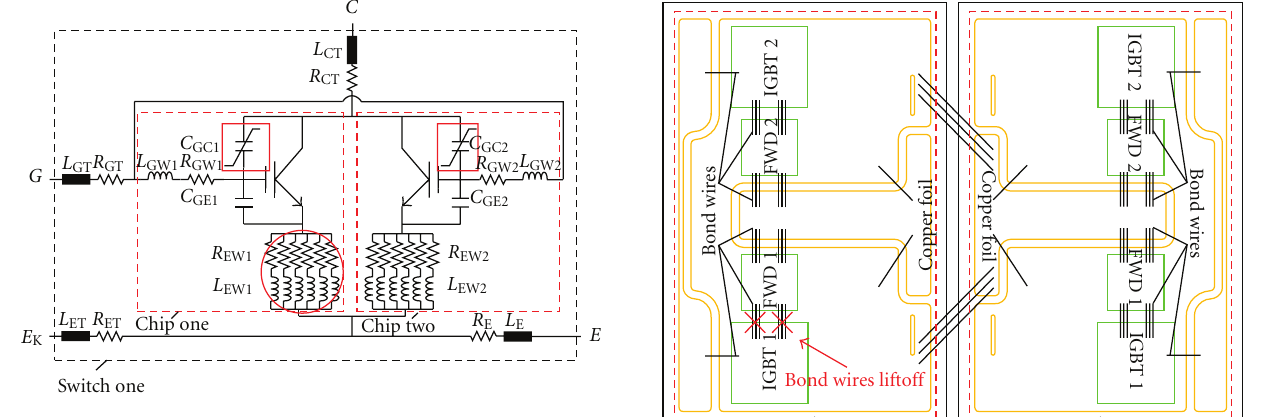
Figure 3: Parasitic elements of one switch inside an IGBT module.